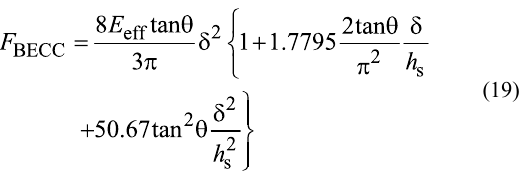
Table 1: Parameters used to compare the performance of the numerical integration algorithms LSODA and Runge–Kutta 4 (RK-4) for z c = 4 nm.